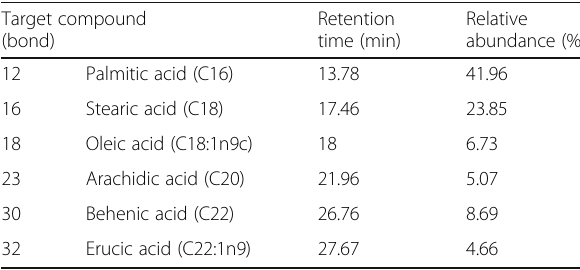
Table 7 Fatty acid compounds detected in latent fingerprint residue from donor A by GC